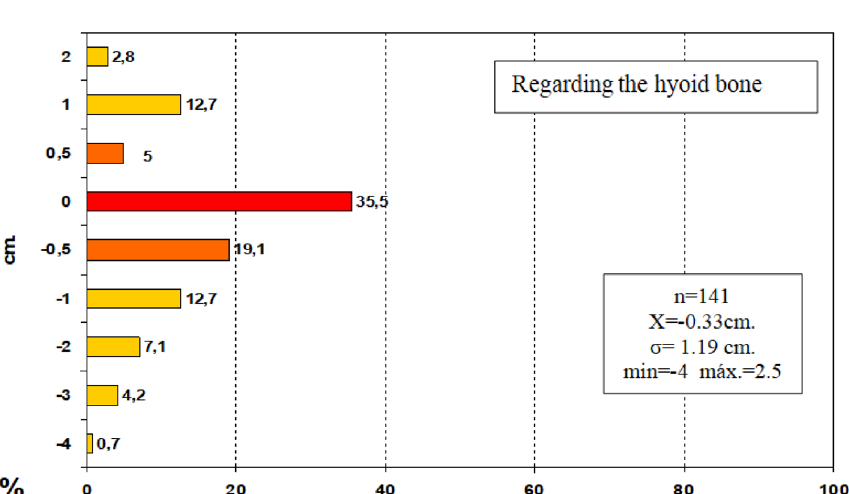
Figure 7. Level of the carotid bifurcation. Negative values are equivalent to heights below the body of the hyoid bone, and positive values are equivalent to heights above the body of the hyoid bone. cm. centimetre, n sample size, X mean, σ standard deviation, min minimum value and max maximum